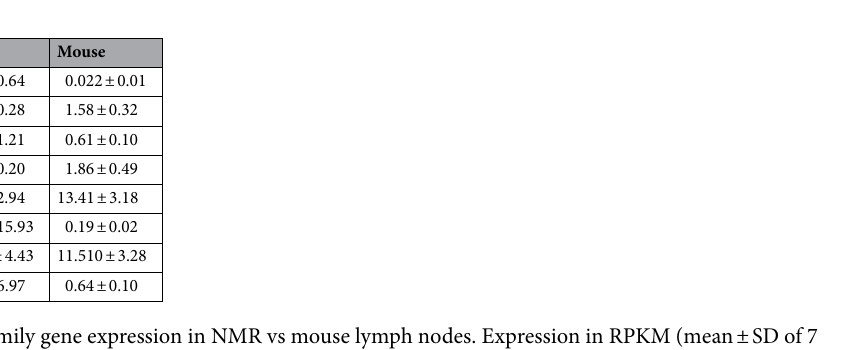
Table 1. HA-family gene expression in NMR vs mouse lymph nodes. Expression in RPKM (mean ± SD of 7 selected HA-family genes ( Has1, Has2, Has3, Hyal1, Hyal2, Hyal3 and Tnfaip6 ) in NMR (n = 4) and mouse (n = 3) lymph